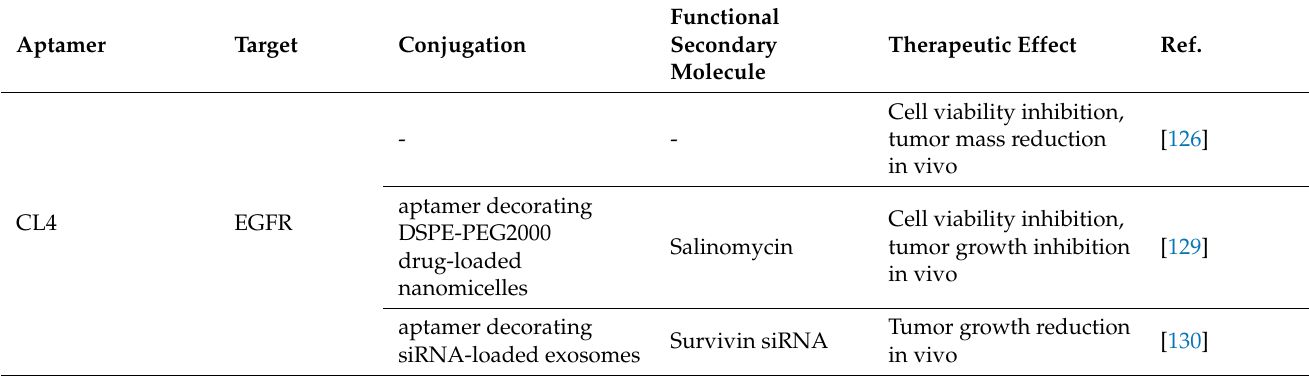
Table 4. Main examples of aptamer and aptamer complexes applied to NSCLC